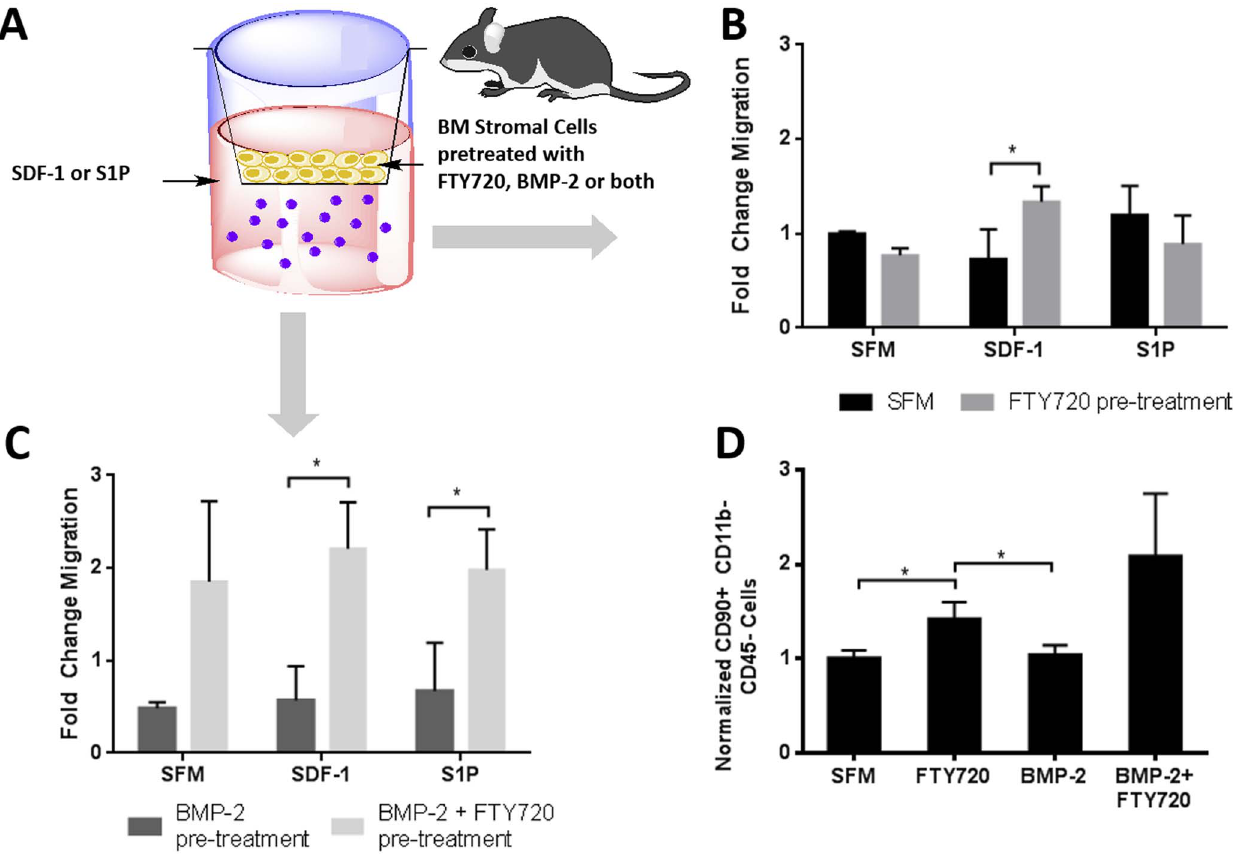
Figure 1. FTY720 increases progenitor cell migration and differentiation. (A) Schematic of transwell assays used to measure the migratory ability of BMSCs pre-treated with FTY720, BMP-2, both or neither towards, serum free media, SDF-1 or S1P. (B) Treatment with FTY720 increases chemotaxis towards SDF-1. (C) Addition of FTY720 to BMP-2 treatment enhances cell motility. (D) Treatment with FTY720 increases SDF-1 mediated chemotaxis of CD90 + cells, as measured by flow cytometry, normalized to SFM. (** p , 0.01 & *p ,